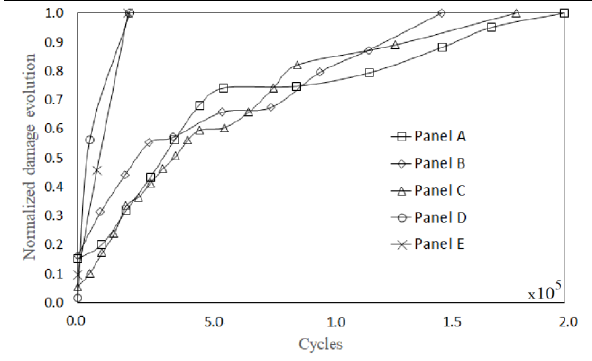
Figure 10. Normalized damage evolution on unmodified panels.